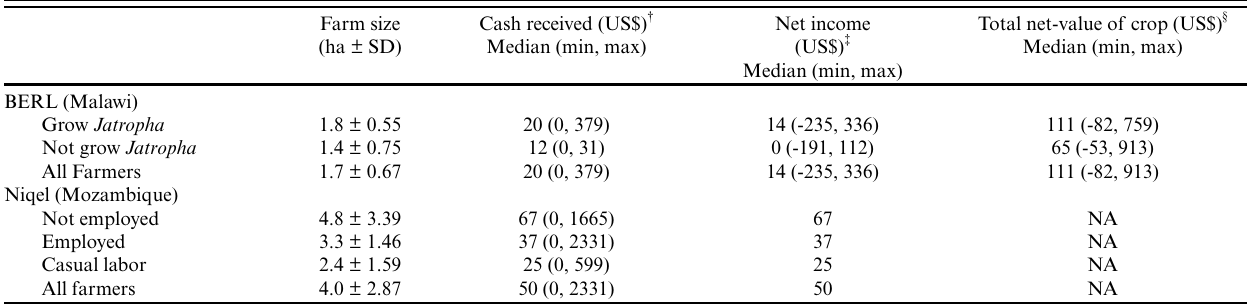
Table 11 . Farm size and value of farm produce, comparing growers and non- Jatropha growers in Malawi and workers on the Jatropha plantation in Mozambique with nonworkers.